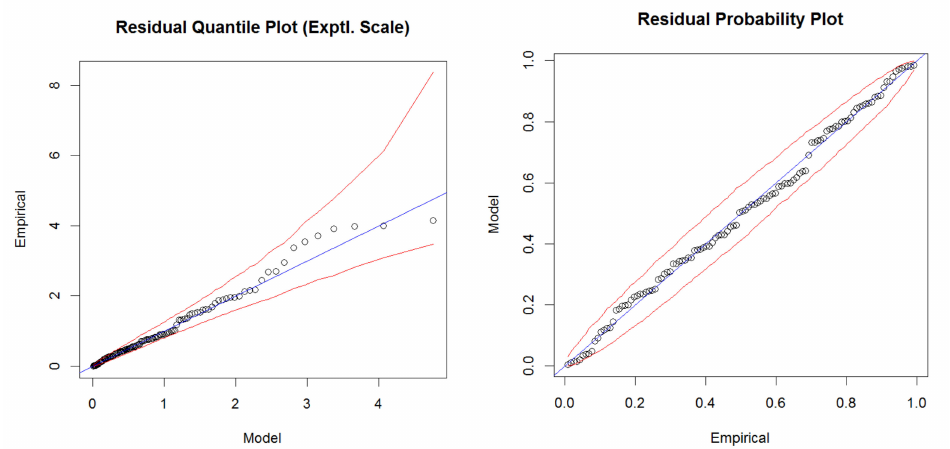
Figure A7. QQ plot ( left ) and PP plot ( right ) for the model when using the data of Salzburg.